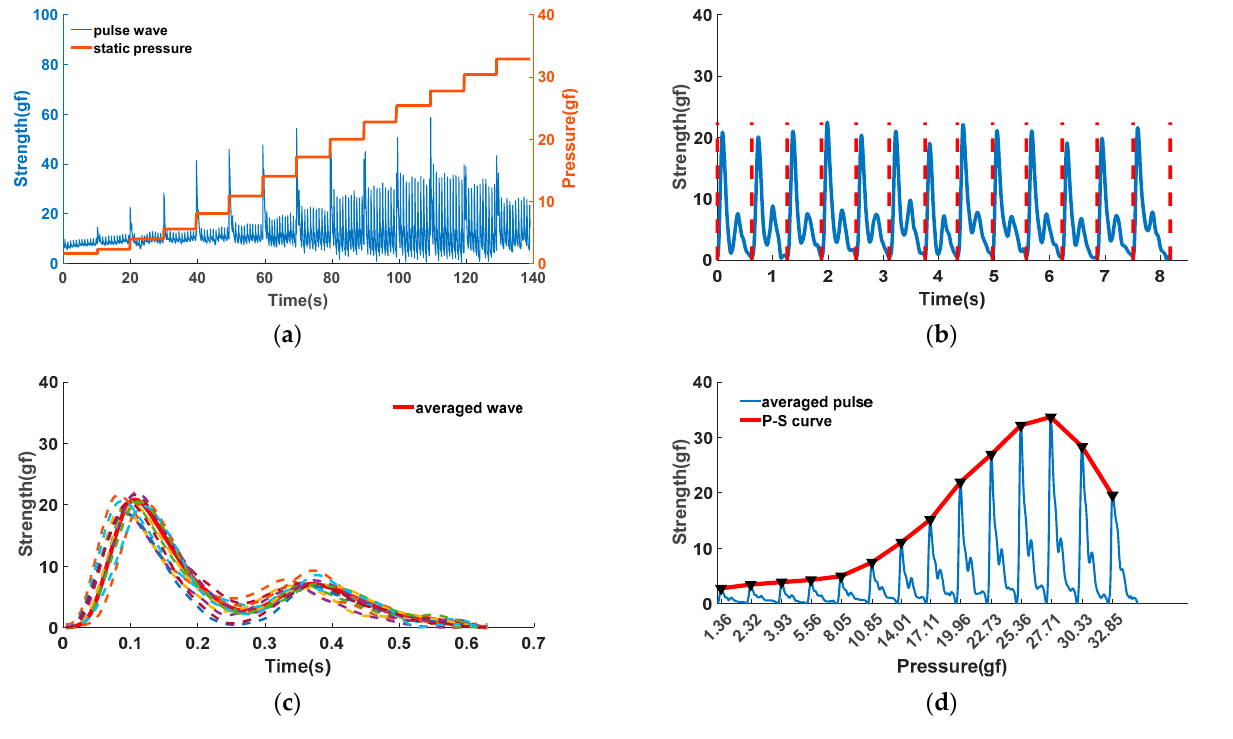
Figure 6. Pulse P-S curve acquisition process: ( a ) raw pulse signal; ( b ) the original signal period division, the red dotted line is the initial boundary of the pulse cycle, and the blue solid line is the actual single cycle pulse waveform; ( c ) time domain averaging of single-period signals, the dotted lines with different colors are the single cycle pulse wave after dividing the cycle, and the solid red lines are the pulse wave after time domain average; ( d ) full pressure segment pulse strength envelope.